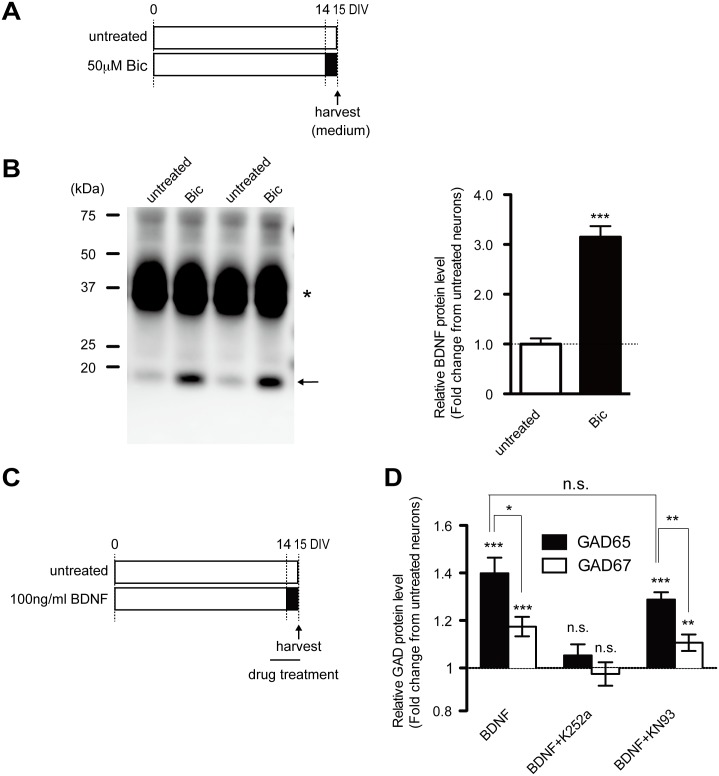
Released BDNF differentially accelerates expression of GADs under conditions of increased activity.(A) Cultured cortical neurons were treated with 50 μM bicuculline on DIV14 for the final day in the culture, and the conditioned medium was harvested on DIV15. (B) Level of released BDNF from cultured cortical neurons after treatment with bicuculine as shown in (A). (n = 6) Arrow shows mature BDNF. Note that the asterisk is an unknown, unspecific band (not pro-BDNF) because a previous study used the same antibody that was detected in BDNF knockout mice. [22] (C) Recombinant human BDNF (100 ng/mL) is applied to cultured cortical neurons for 24 hours with or without inhibitors. (D) Relative GAD protein levels after treatment with BDNF. The increased expression of GAD65 and GAD67 is inhibited by K252a but not by KN93. Note that BDNF preferentially enhances GAD65 expression over that of GAD67. GAD67: F(3, 38) = 19.35 (p < .0001); GAD65: F(3, 25) = 21.78 (p < .0012), one-way ANOVA. (n = 6–10 in each group).